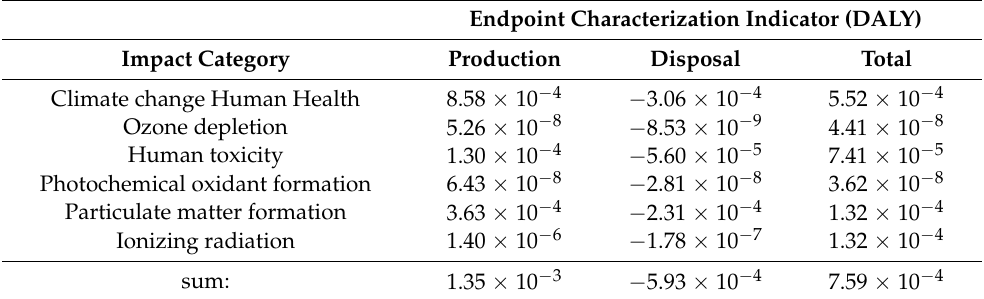
Table 2. Endpoint characterization indicators computed for the silencer production and